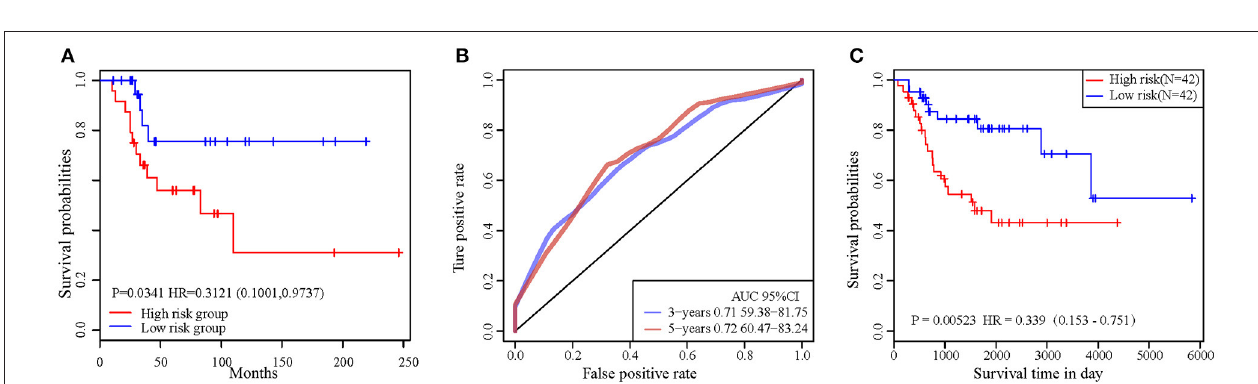
FIGURE 6 | (A) The prognostic differences between the two groups in external validating dataset was significant (log-rank test p = 0.0341). (B) ROC curve in external validation TARGET dataset. (C) 2-gene signature KM curve in external validation TARGET dataset.